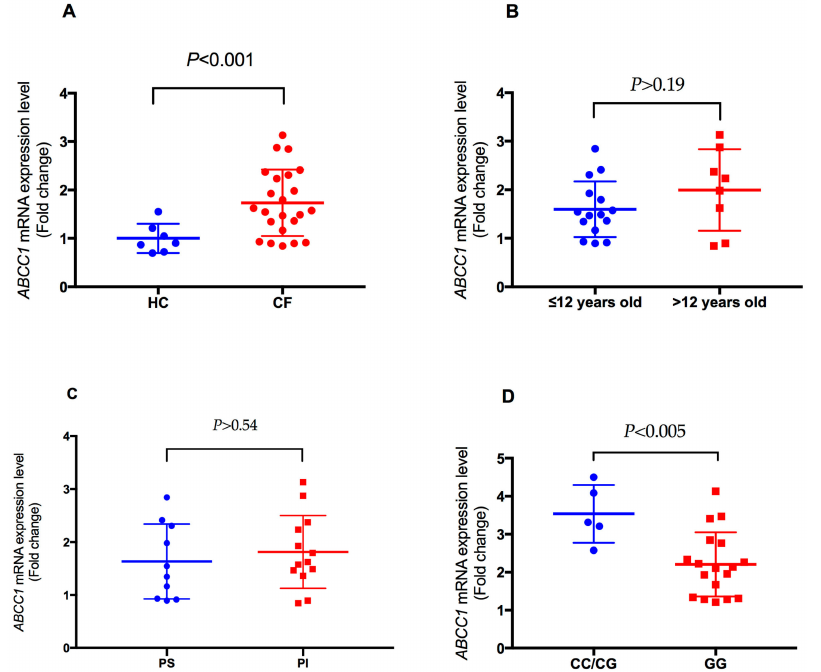
Figure 1. Comparison of plasma-induced ABCC1 mRNA expression levels in PBMC. ( A ) Expression levels were higher for cystic fibrosis (CF) subjects than healthy controls (HC). No difference was observed between young ( ≤ 12 years of age) and old (>12 years of age) CF subjects ( B ) or between pancreatic insufficient (PI) and pancreatic sufficient (PS) CF patients ( C ). Significantly higher ABCC1 expression was induced with plasma from CF subjects with rs504348 (CC/CG) compared to homozygotes with the ancestral G allele ( D ). Significance estimated using t